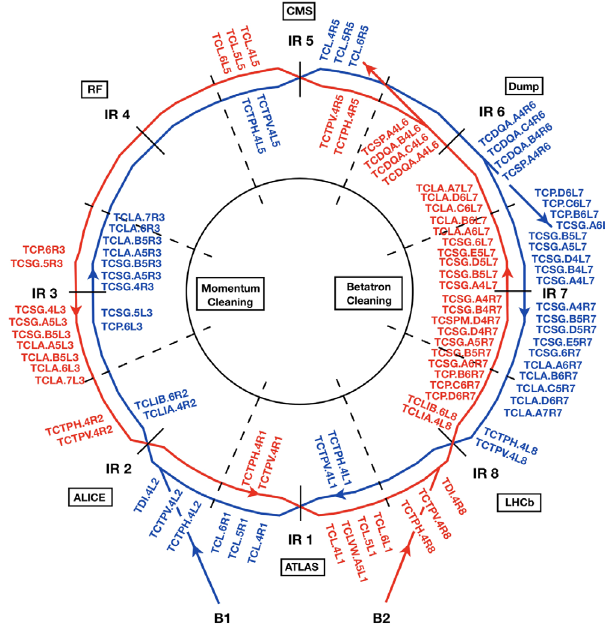
downstream.FIG. 1. The present collimation system layout with the majority